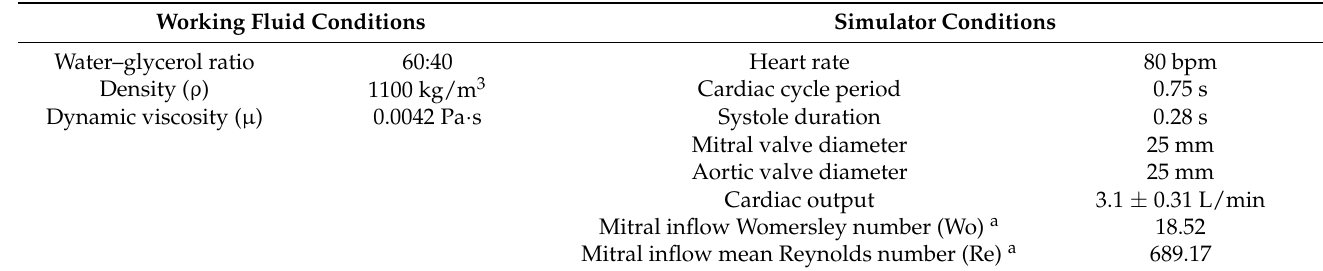
Table 1. Summary of experimental